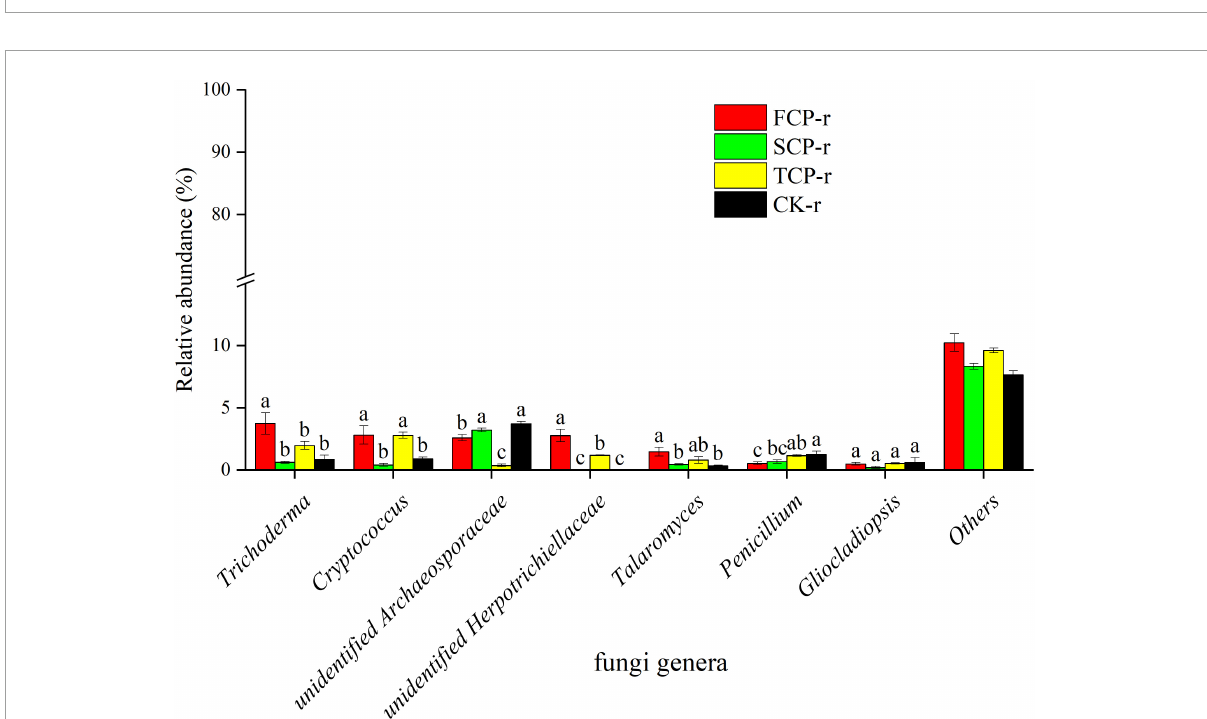
FIGURE5 Relative abundance of predominant fungal community in successive generations within rhizosphere soil at the genus level. Other stands for undefined categories. Value show means ± standard error ( n = 3). Different lowercase letters show significant differences. CK, Nanmu seedings; FCP, first-generation seedings; SCP, second-generation seedings; TCP, third-generation seedings. r, rhizosphere